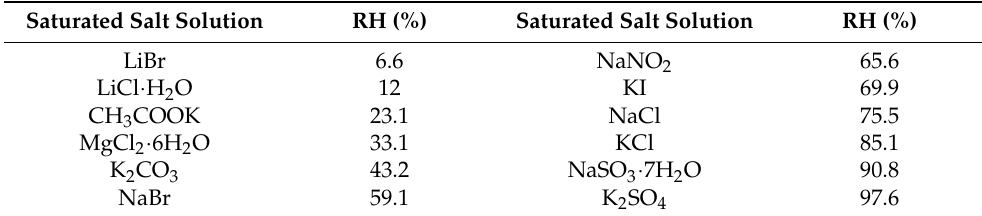
Table 3. Saturated salt solution and its corresponding relative humidity. Saturated Salt Solution